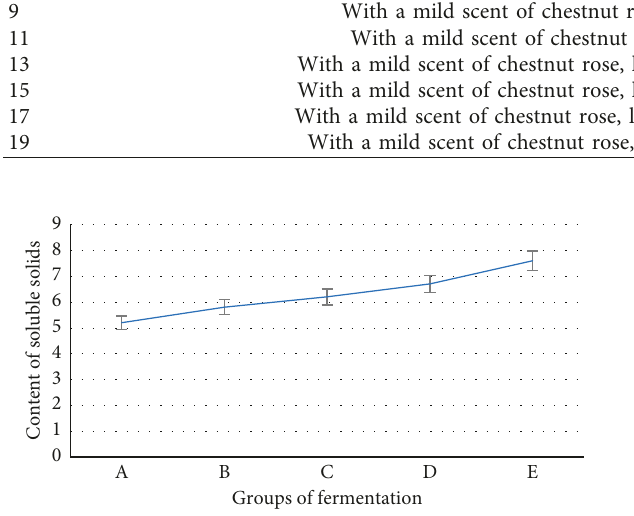
Figure 9: Variation of soluble solids with sugar addition.